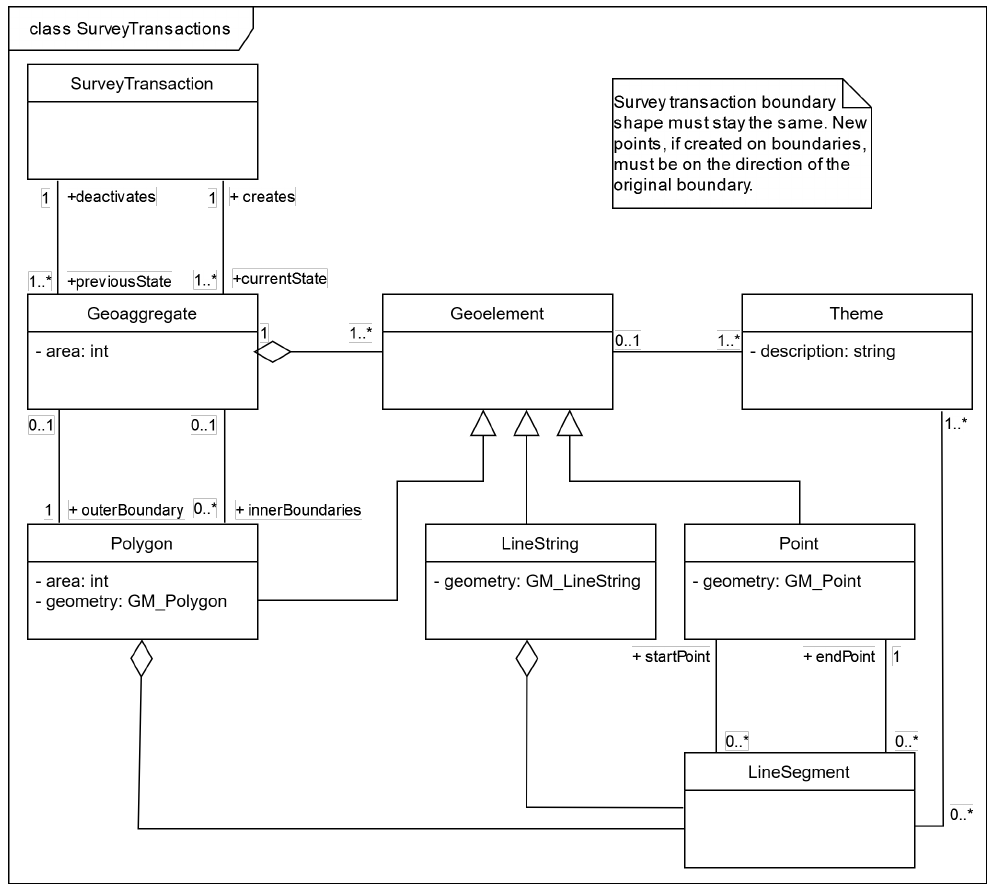
Figure 3. Survey transactions’ domain model.